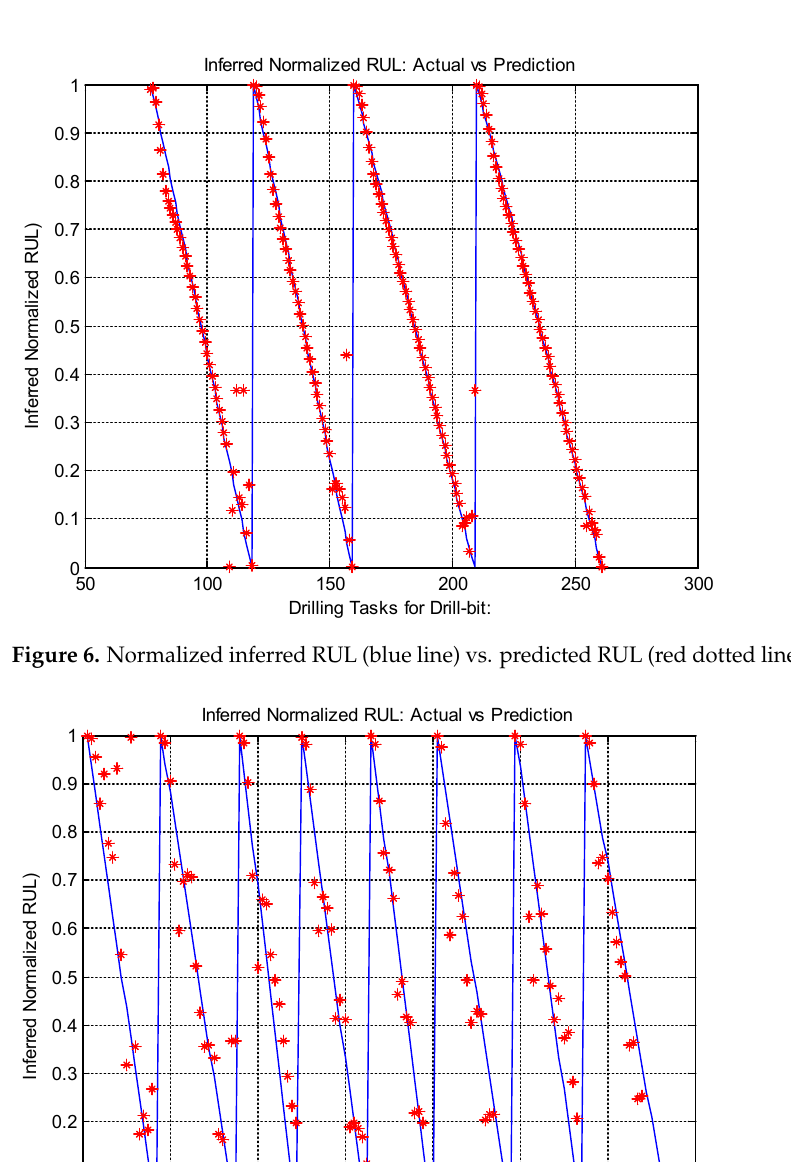
Table 1. Cluster assignment history of drill-bits #1 ~ #4.